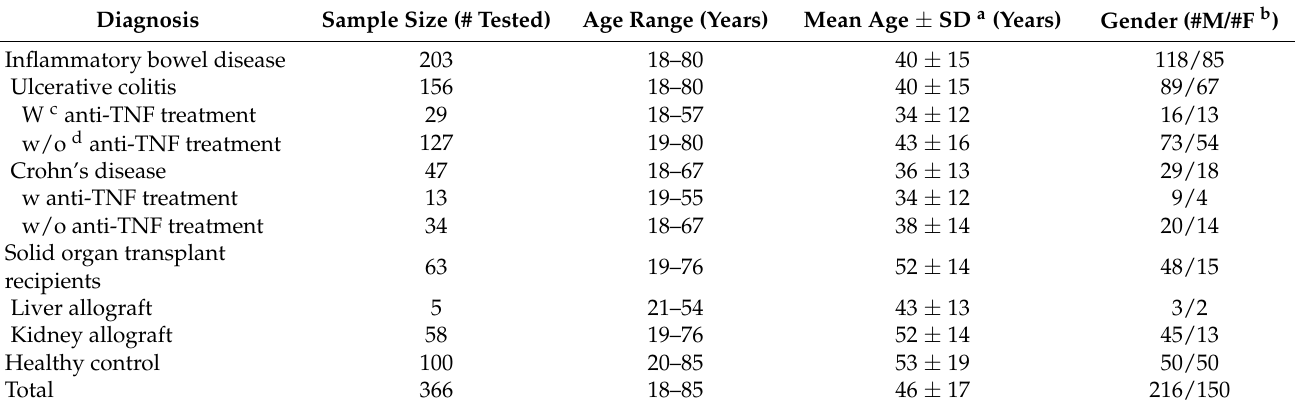
Table 1. Characteristics of studied and control